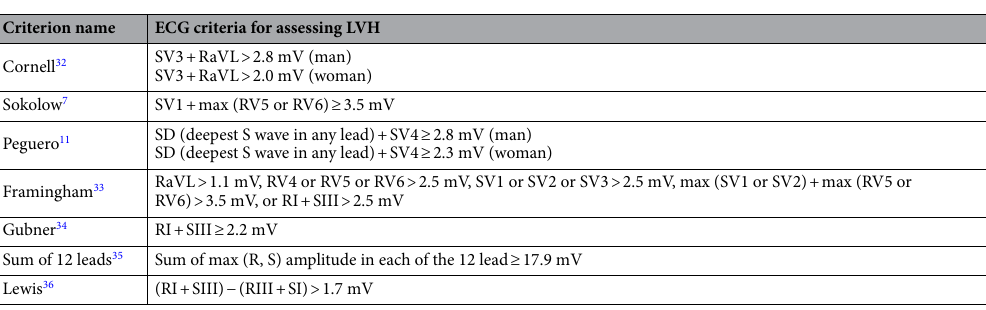
Table 1. Seven methods, ECG-based criteria, for assessing